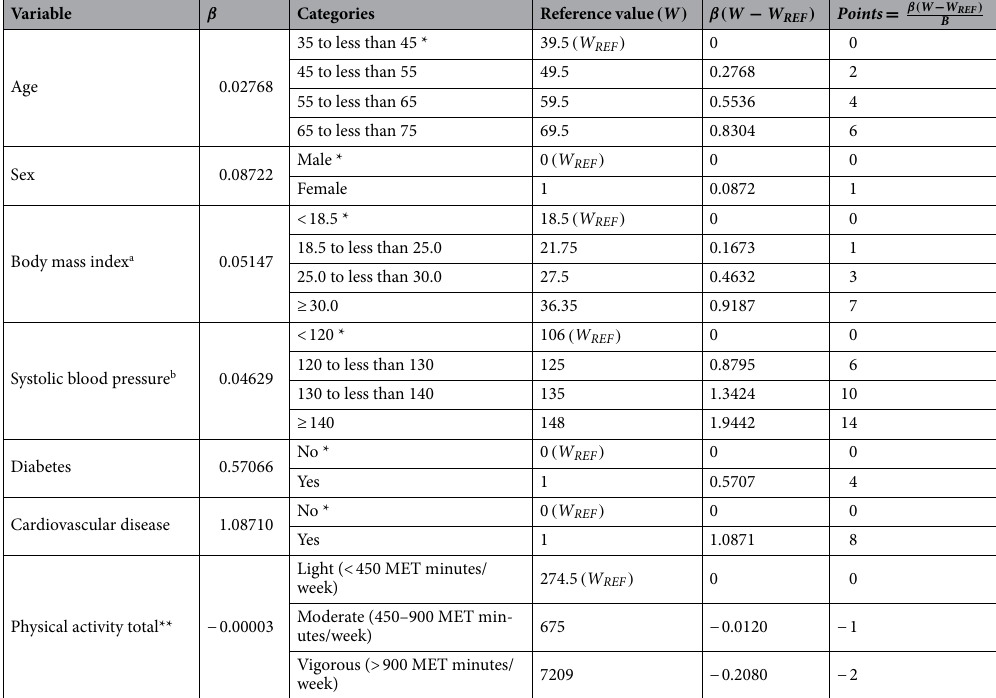
Table 4. Calculation of point values for risk score *Reference category. The age range in the sample is 35–70. a The range of body mass index is 12.5–64.9. To determine the reference values for the first and last categories, we use the 1st percentile (18.5) and the 99th percentile (42.7) to minimize extreme values’ influence. **The range of physical activity total is from 33 MET minutes/week to 19,278 MET minutes/week. To determine the reference values for the first and last categories, we use the 1st percentile (99) and the 99th percentile (13,518) to minimize extreme values’ influence. b The range of systolic blood pressures is 76–205. To determine the reference values for the first and last categories, we use the 1st percentile (92) and the 99th percentile (156) to minimize extreme values’ influence. The constant for the points system or the number of regression units will correspond to one point. Here, we let B reflect the increase in risk associated with a 5-year increase in age: B = 5 ( 0.02768 ) = 0.1384